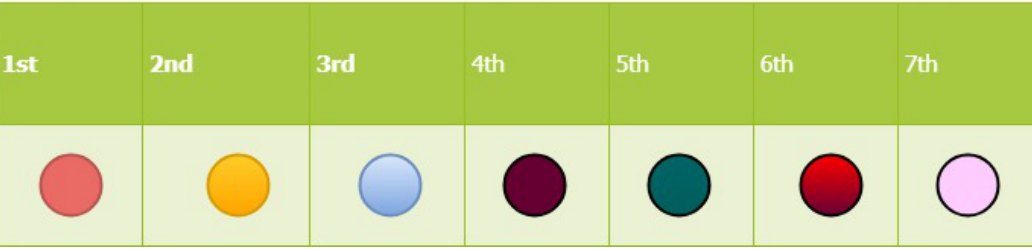
Figure 4. Reliable Nodes